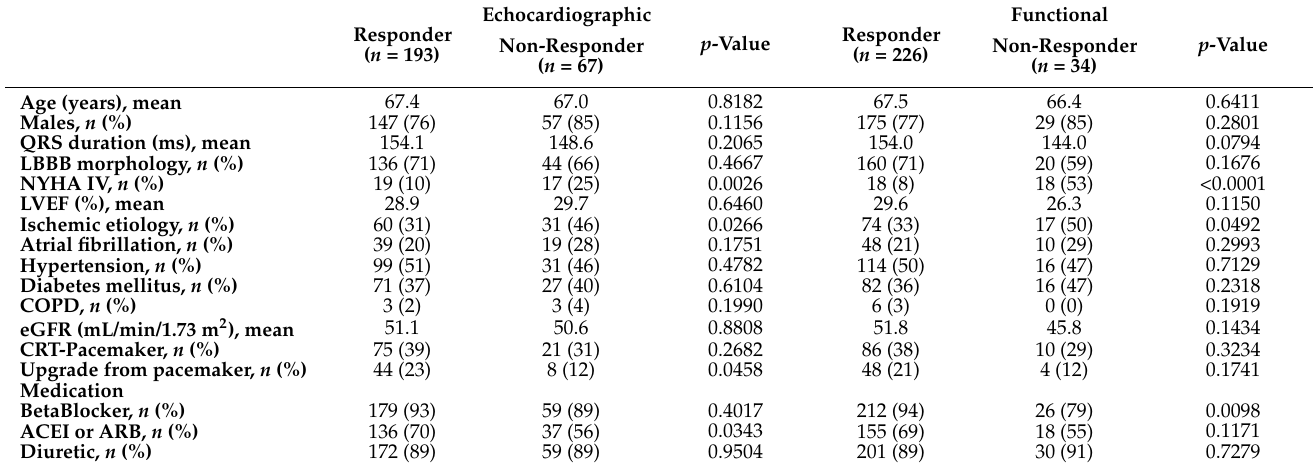
Table 2. Characteristics of responders and non-responders.